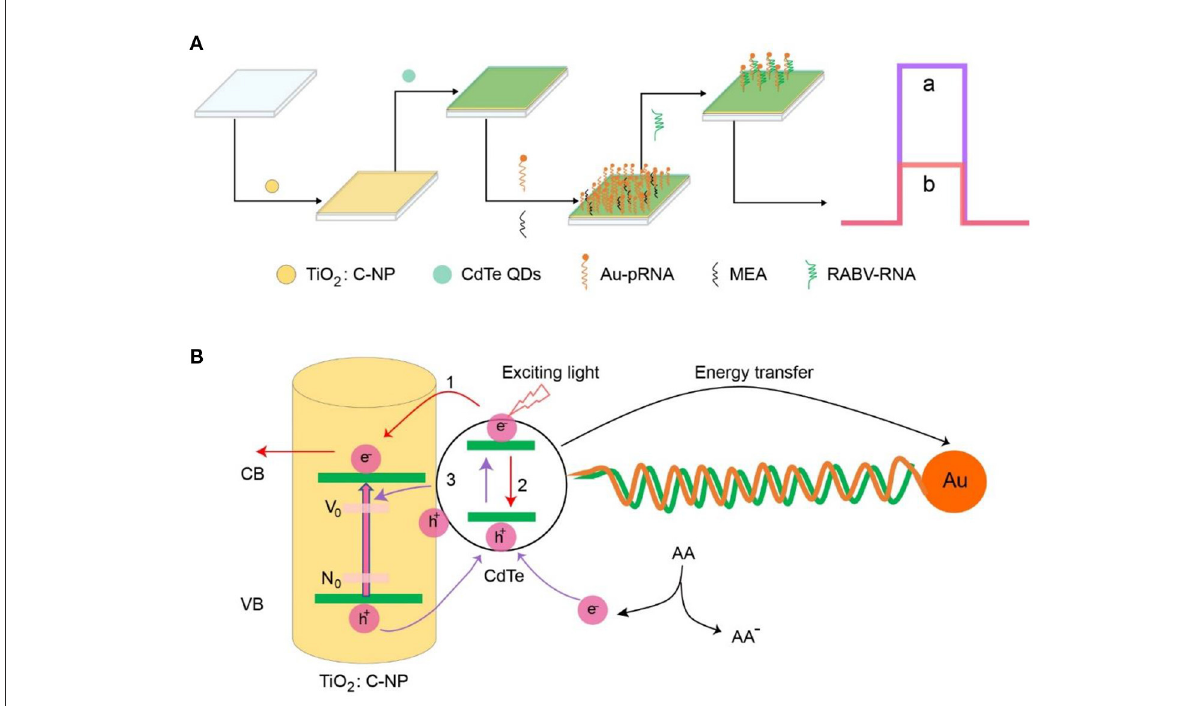
the XPS spectrum of TiO 2 :C-NPs, again confirming that C was successfully doped into the TiO 2 NPs.